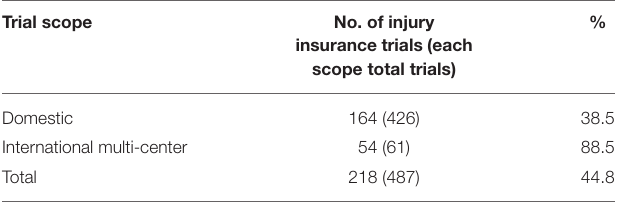
TABLE 1 | Domestic and international multi-center trial-related injury insurance.